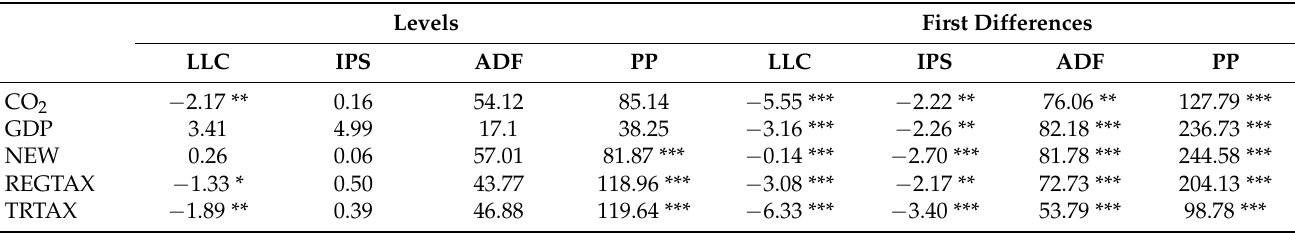
Table 3. Panel Unit Root Tests Results.